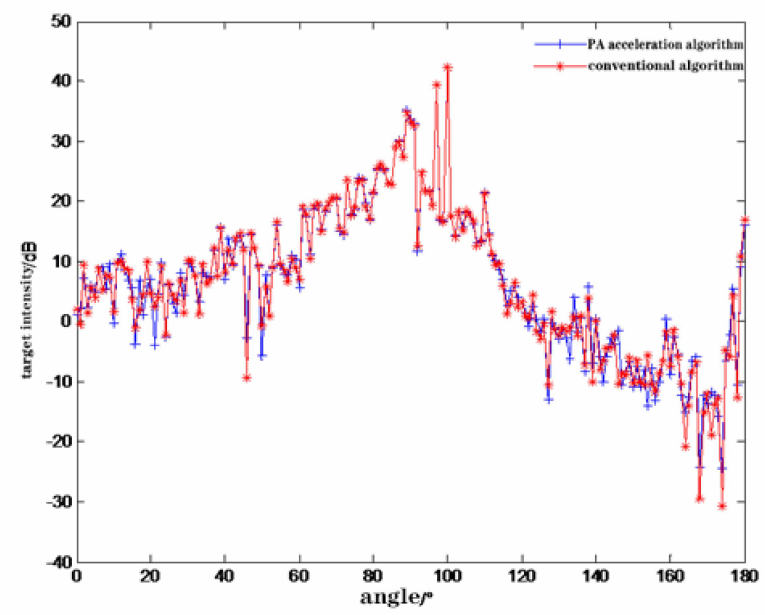
Figure 14. Comparison of the PA acceleration algorithm and conventional integral dimension reduction